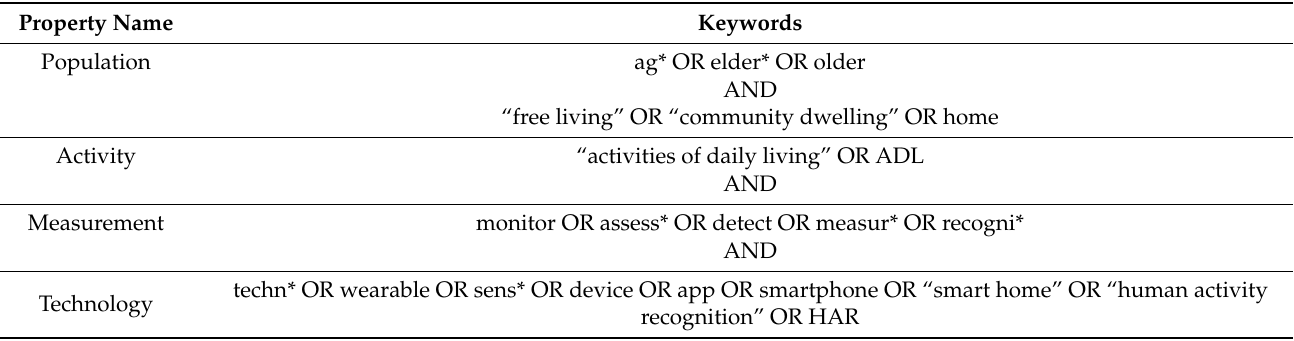
Table 2. Search terms used to identify the appropriate published research.